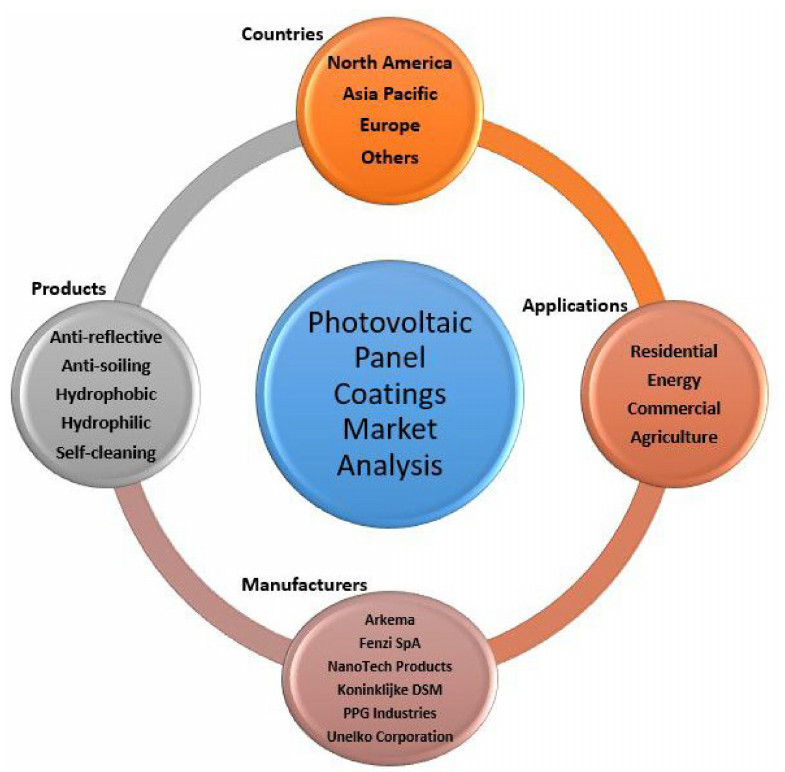
Figure 16. Solar panel coatings market segmentation analysis. Adapted from